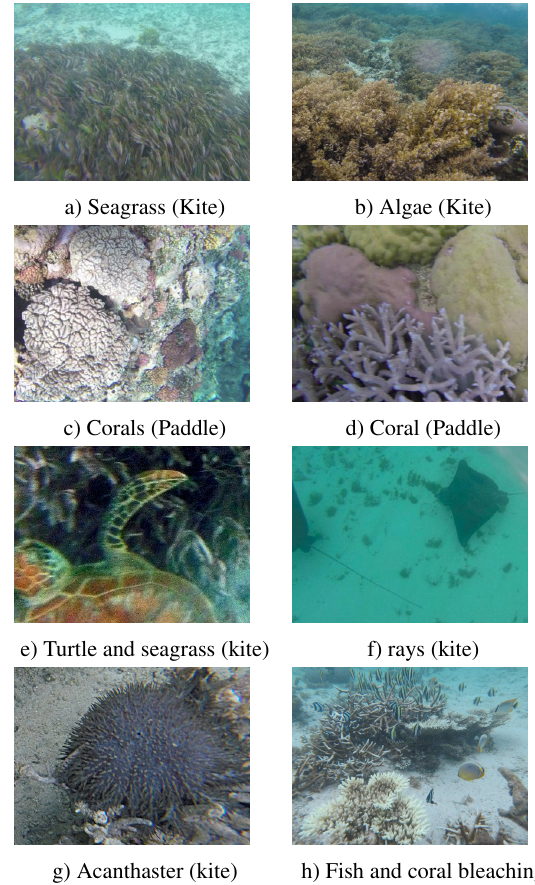
Figure 5. Examples of underwater pictures